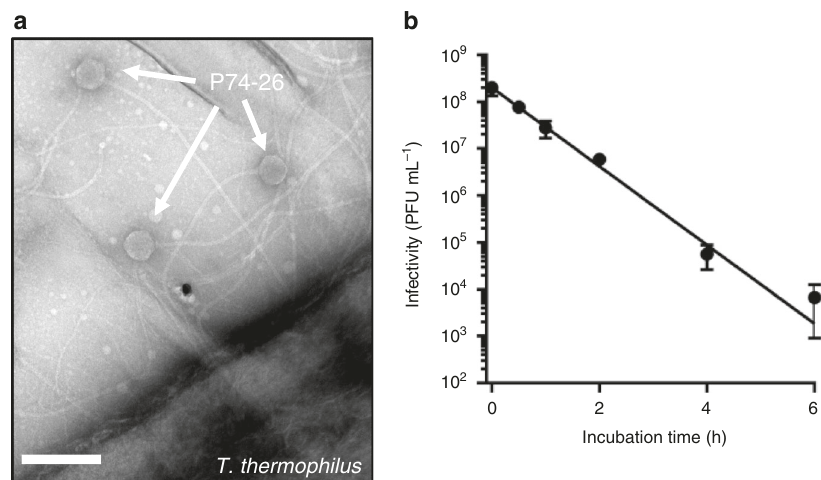
Fig. 1 P74-26 is a thermostable virus. a Negative stain electron micrograph of phage P74-26 infecting T. thermophilus HB8; scale bar, 200 nm. b Puri fi ed P74-26 virions retain signi fi cant infectivity after 80 °C incubation; error bars = standard deviation calculated from n = 3 independent experiments. Source data for this experiment are provided as a Source Data fi